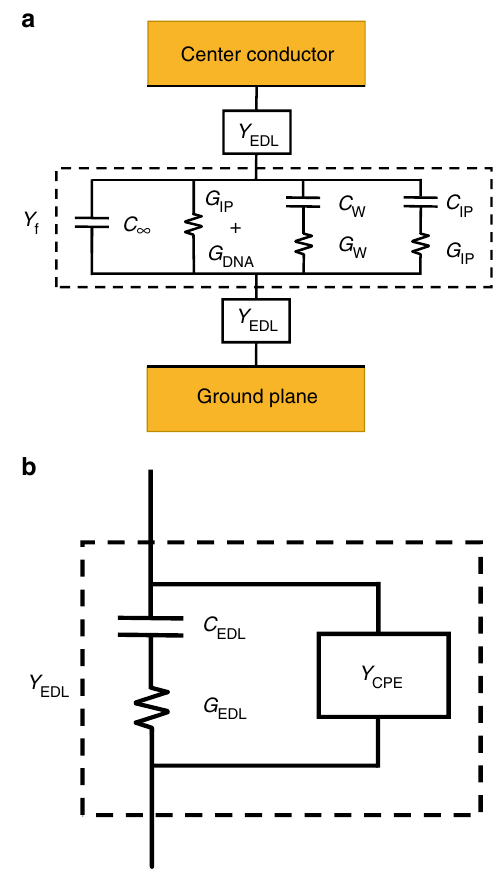
Fig. 4 Circuit model for DNA tweezers suspended in TAE-Mg 2 + buffer. a Total fl uid admittance Y tot is comprising the EDL admittance Y EDL in series with Y f . b Equivalent circuit of Y EDL , where Y CPE is the admittance of the constant-phase element (CPE), and C EDL and G EDL represent the Debye relaxation form of the